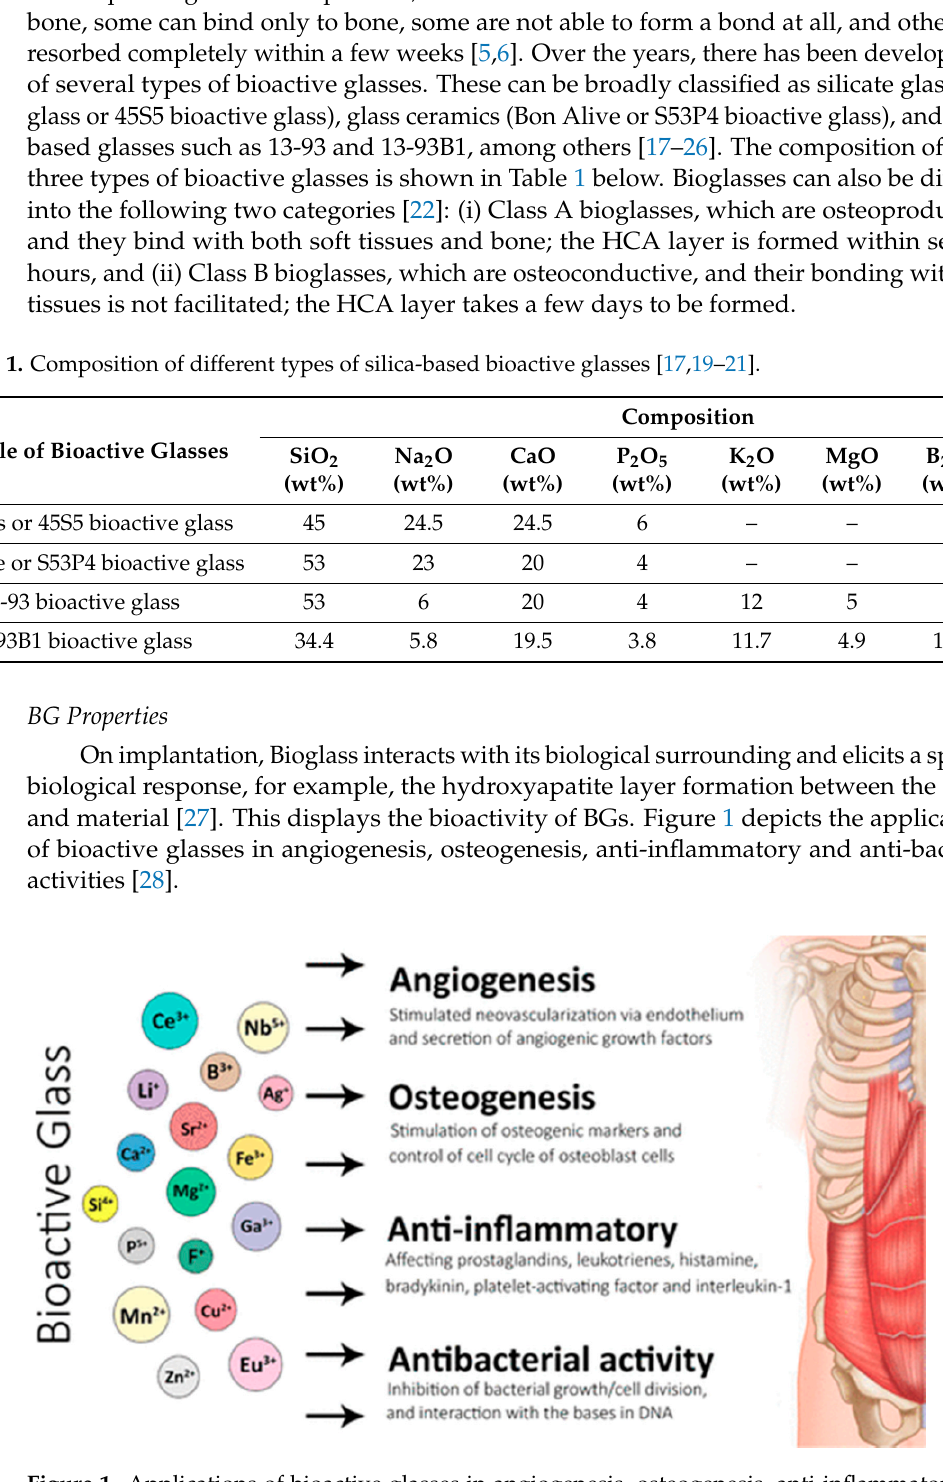
Figure 1. Applications of bioactive glasses in angiogenesis, osteogenesis, anti-inflammatory and anti-bacterial activities